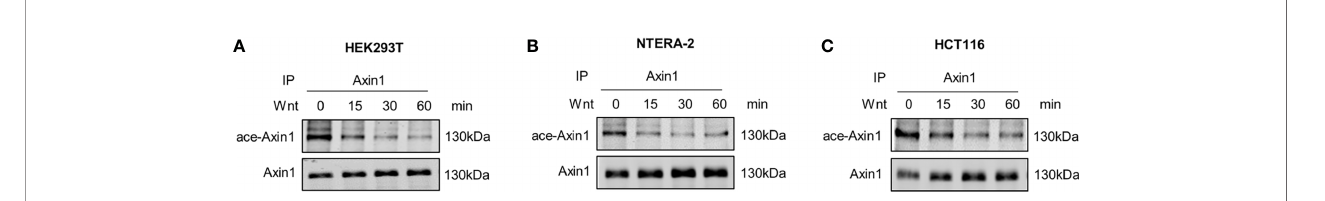
FIGURE 1 | Axin1 is deacetylated during Wnt signaling pathway activation. (A) HEK293T (human embryonic kidney 293 cell), (B) NTERA-2 (pluripotent human embryonic carcinoma cell), (C) HCT116 (human colorectal carcinoma cell) cells were stimulated with Wnt3a-conditioned medium. Cell lysates at the indicated time points were collected and subjected to immunoprecipitation with anti-Axin1 antibody. The precipitated Axin1 protein was then subjected to SDS-PAGE followed by western blot analysis with the indicated